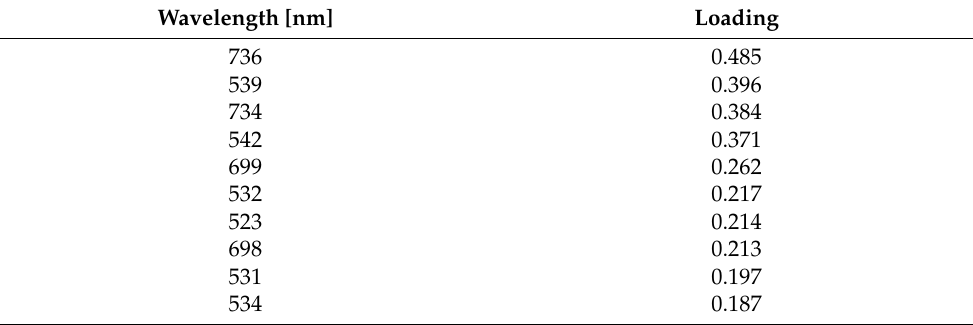
Table 4. Top 10 wavelength which have high loadings for PC1 and